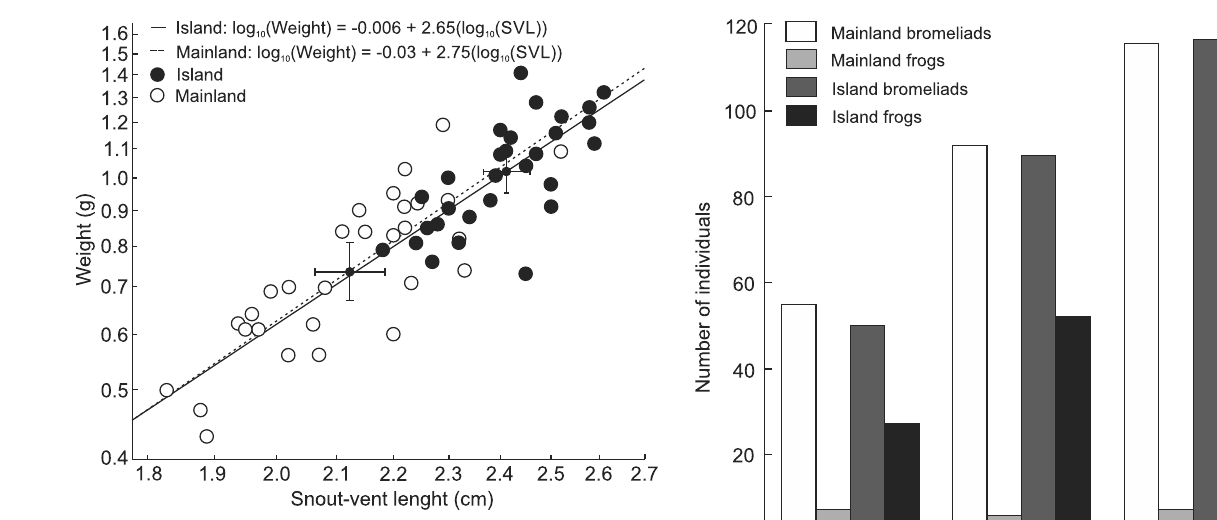
Figure 2. Scatterplot (log scaled on both axes) of weight (g) by 10 snout-vent length (SVL) on the mainland and island, illustrating variation found on each and that both tend to be greater on the Figure 3. Comparison of the number of bromeliads (similar den- island. The smaller symbols with error bars are the bivariate means sity on the island and mainland) and number of individuals of P. with their 95% confidence intervals. We show the individual re- luteolus (more abundant on the island) by sampling plot on the gression lines for illustrative purposes, while the two regressions island and the were not statistically different (see text).